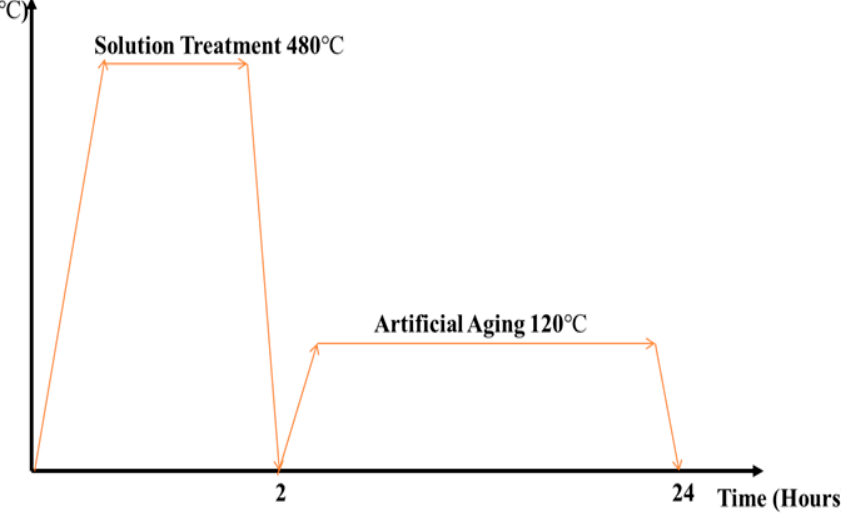
Figure 4. Heat treatment process.